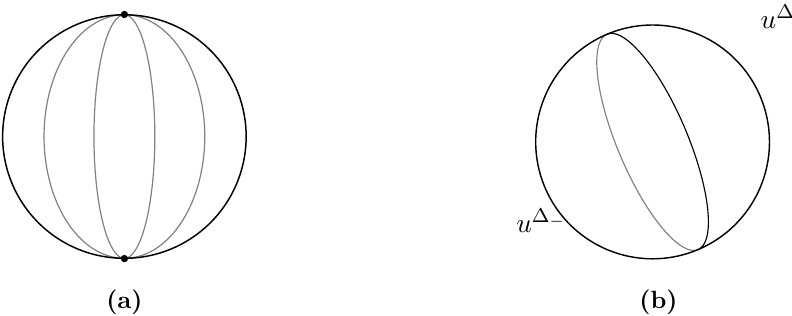
Figure 1. (a) Janus coordinates: H d +1 is sliced by copies of H d , which intersect along the defect. (b) Mixed boundary conditions on the two halves of the boundary of H d +1